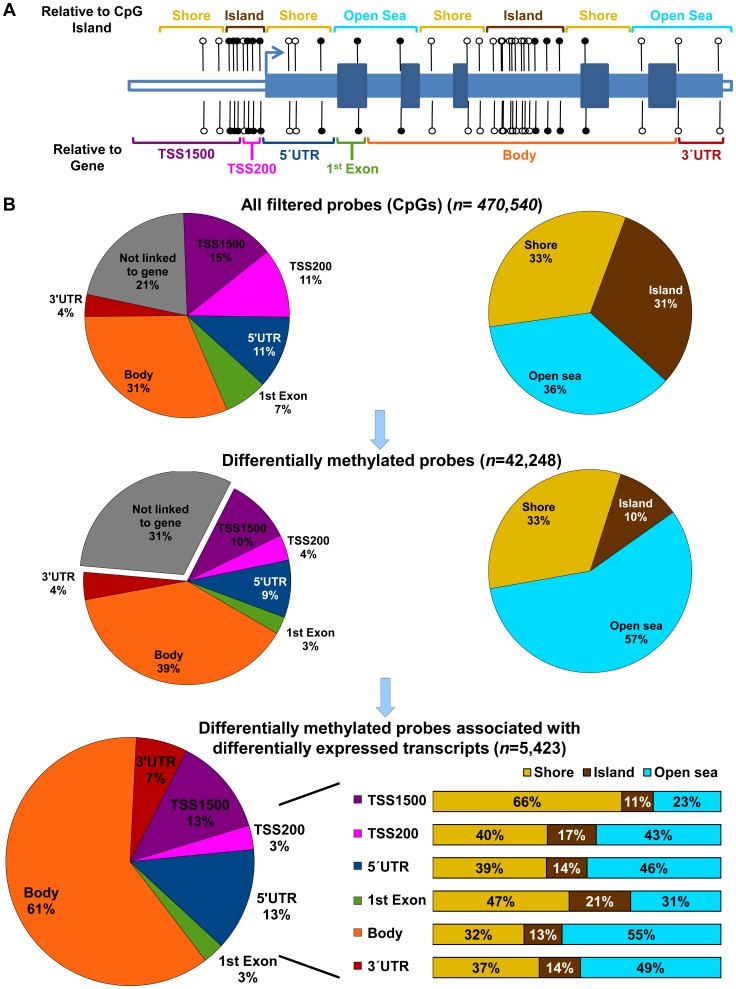
Genomic context of CpG methylation.A schematic diagram of CpGs (A) depicts their genomic context relative to the nearest CpG island (top) or gene (bottom). Island context was defined similarly to the Illumina manifest (see material and methods) as being within an “island” (brown), in a 4kb “shore” flanking the island (yellow), or in an “open sea” more than 4kb from an island. Gene context was defined relative to the nearest open reading frame being: within 1500 (TSS1500; purple) or 200 bp (TSS200; pink) of a transcription start site; in the 5′UTR (green), the 1st exon of a transcript (green); in the body of gene (orange) or the 3′UTR (red). Pie charts (B) show the distribution of the CpGs examined based upon their genomic context for all probes retained from the array (top), for all the probes identified as differentially methylated between OSIS- and EIUM- (middle), and for all the differentially methylated probes that were matched to differentially expressed transcripts (bottom; note that stacked bar graphs show the CpG island context broken down for each of the gene contexts.).